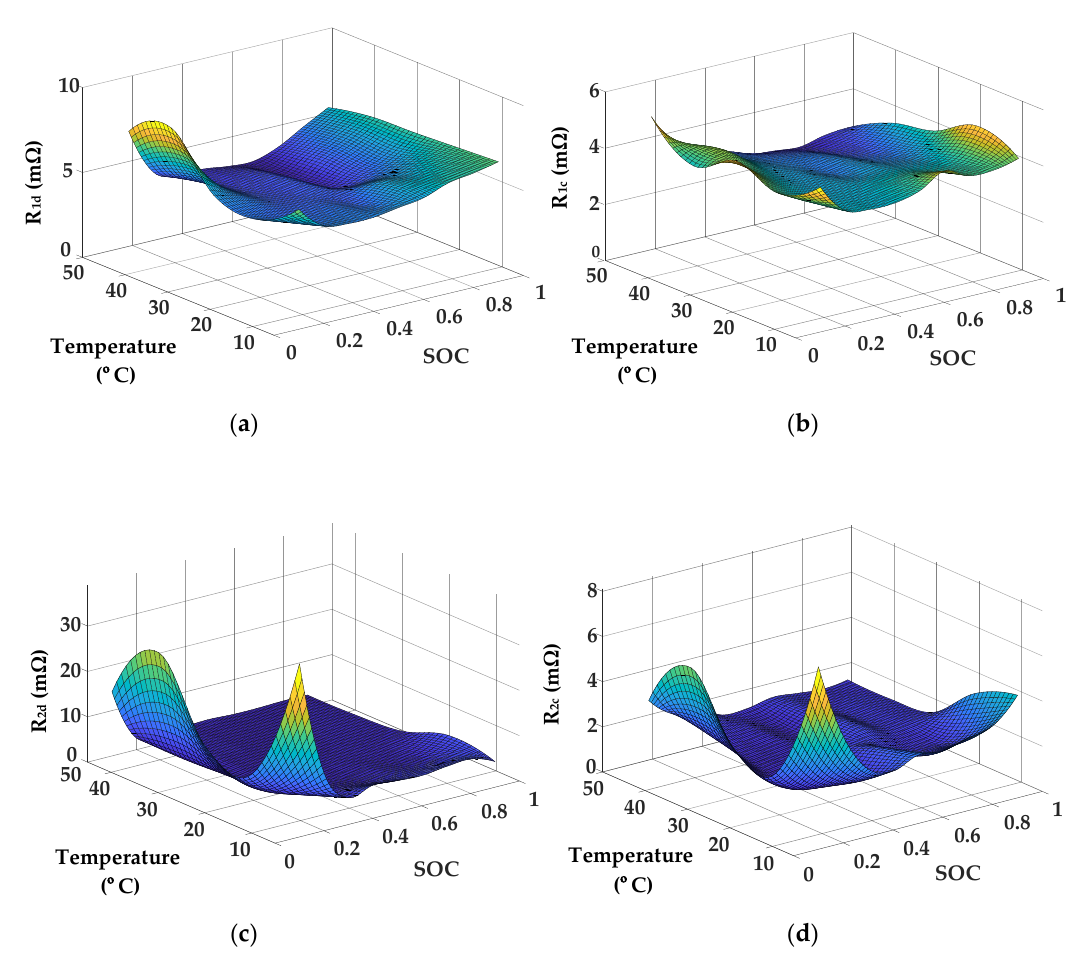
Figure 6. Polarization internal resistance identification results: ( a ) identified internal resistance for discharging, R 1d ; ( b ) identified internal resistance for charging, R 1c ; ( c ) identified internal resistance for discharging, R 2d ; and ( d ) identified internal resistance for charging, R 2c .